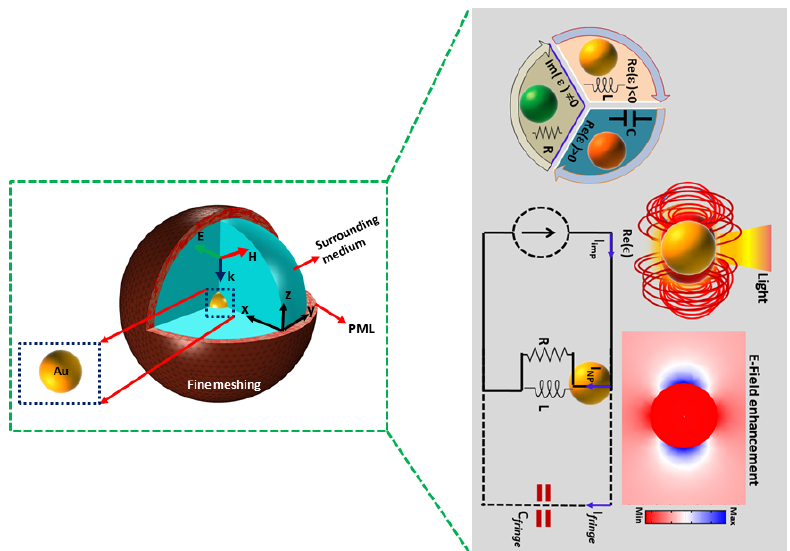
Figure 1. A 3D Schematic diagram for numerical simulation analysis. The Au NP is immersed in surrounding medium ( n = 1) at the center of spherical domain and incident field is illuminated in the opposite direction of Z-axis of the domain.The whole computational domain is equivalent to nanocircuit for single Au